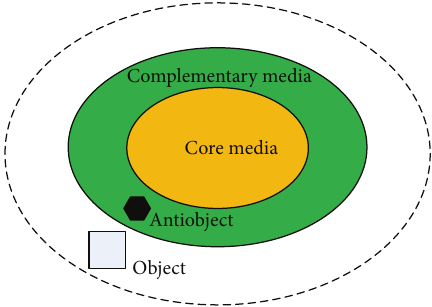
Figure 1: The external cloak based on the complementary media.